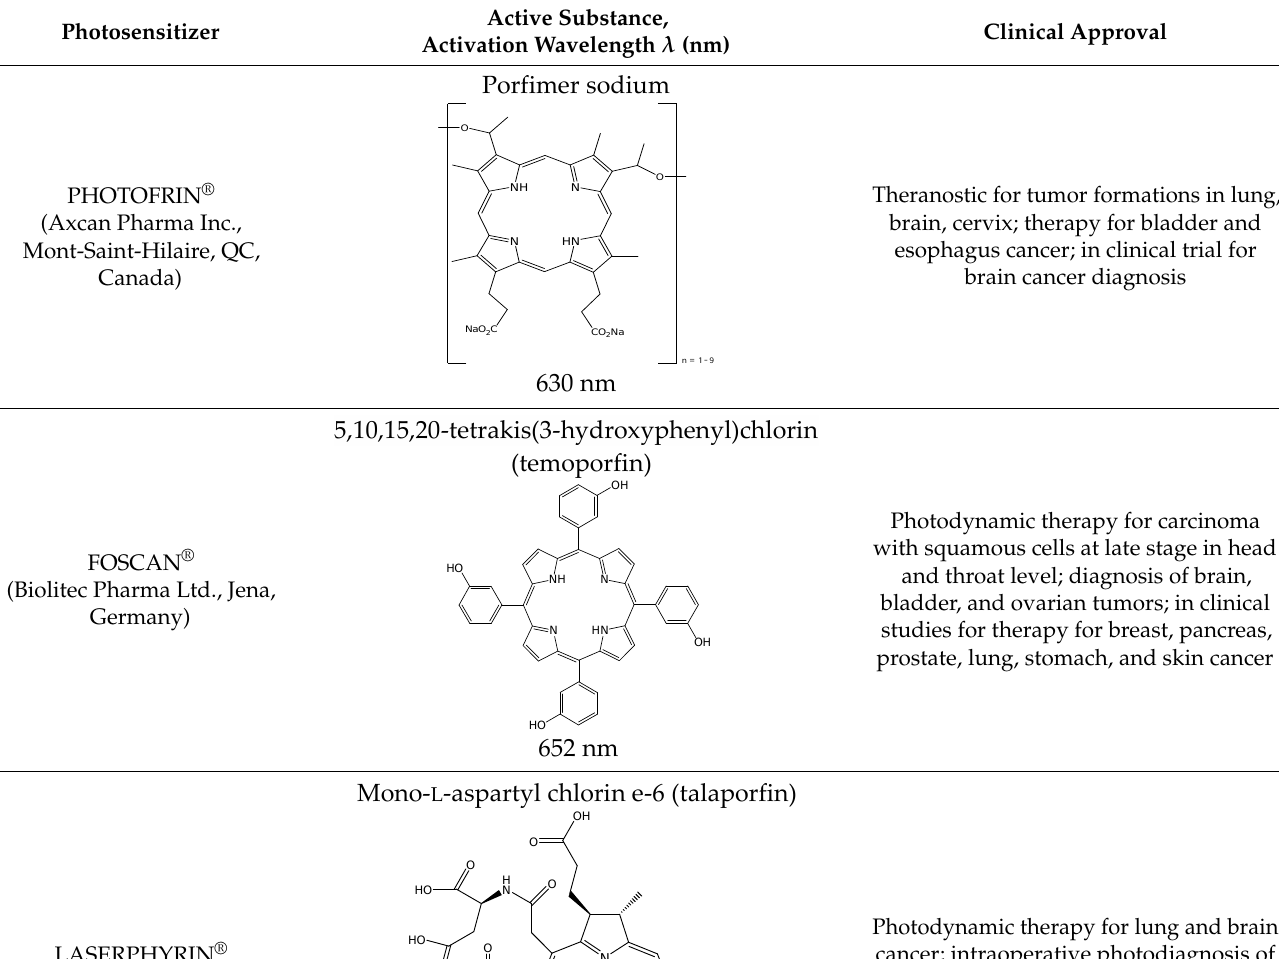
Table 1. General presentation of photosensitizers with macrocycle structures approved or in clinical trials for diagnosis and photodynamic therapy of cancer [99–104].